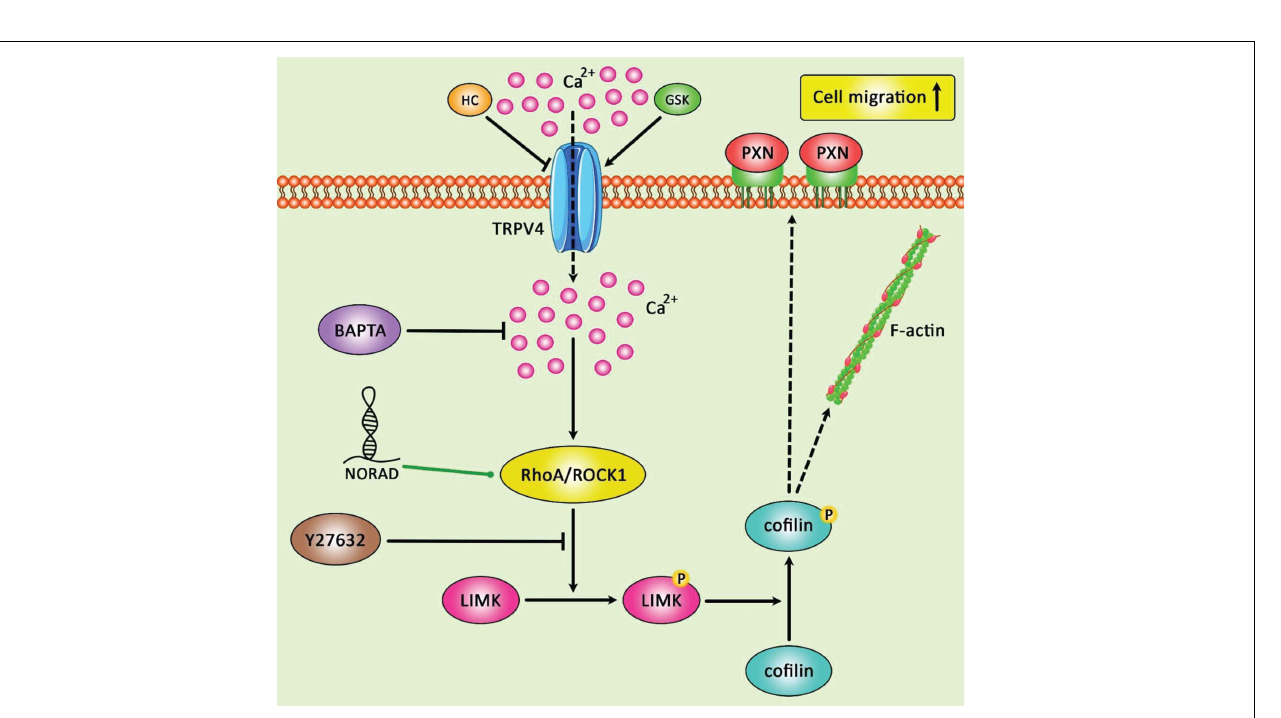
Frontiers in Cell and Developmental Biology |